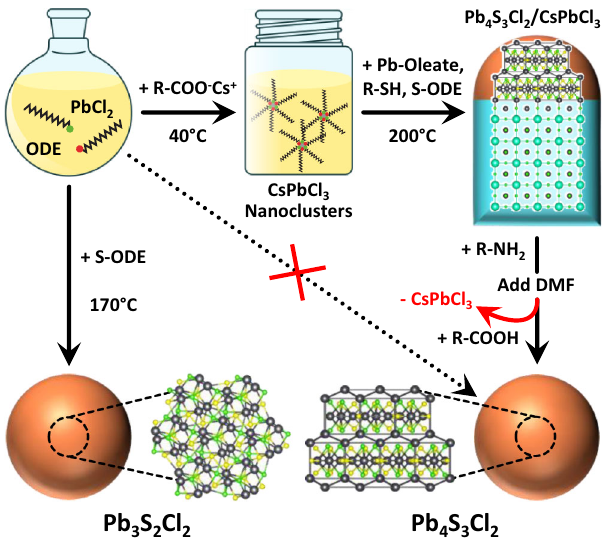
Fig. 1 Phase-selective templated synthesis of lead sulfochloride NCs. A solution of PbCl 2 reacts with sulfur dissolved in 1-octadecene (S-ODE) to form Pb 3 S 2 Cl 2 NCs. When reacted with Cs-oleate (R-COO - Cs + ) it produces instead CsPbCl 3 nanoclusters, that can be further reacted with Pb-oleate, S-ODE, and an alkyl thiol (R-SH) to form Pb 4 S 3 Cl 2 /CsPbCl 3 heterostructures. The CsPbCl 3 domain can be then selectively etched by the sequential addition of oleylamine (R-NH 2 ), dimethyl formamide (DMF), and oleic acid (R-COOH), yielding colloidally stable Pb 4 S 3 Cl 2 NCs that could not be obtained by direct synthesis. Atoms color code: Cs = cyan; Pb = gray; S = yellow; Cl =